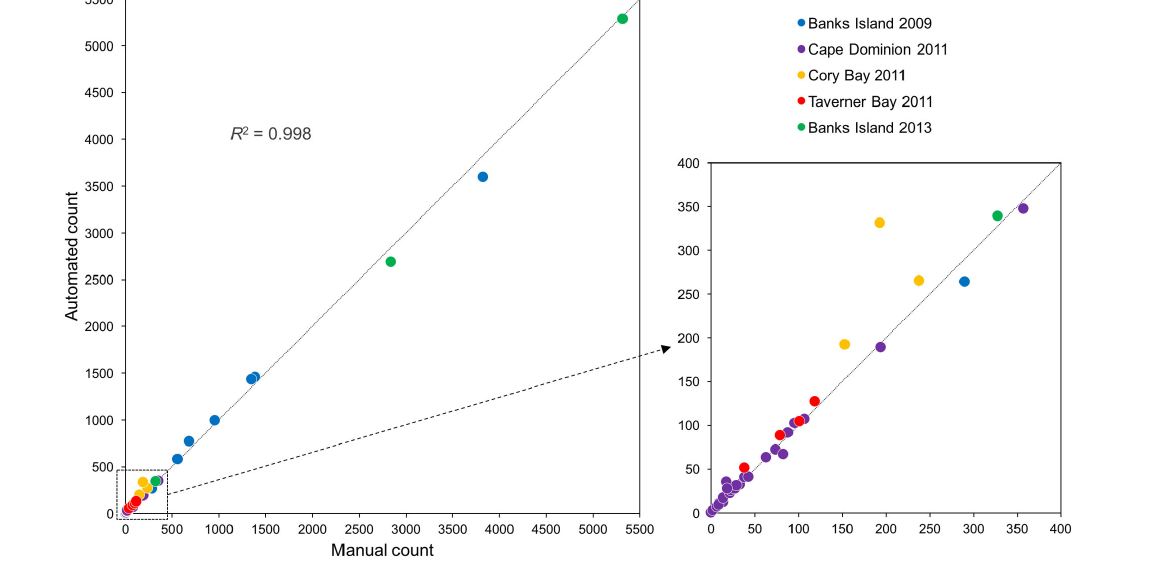
Fig. 11 . Scatter plot of semiautomated counts vs. manual counts of Lesser Snow Geese ( Chen caerulescens caerulescens ) in 41 aerial images of breeding colonies in the Canadian